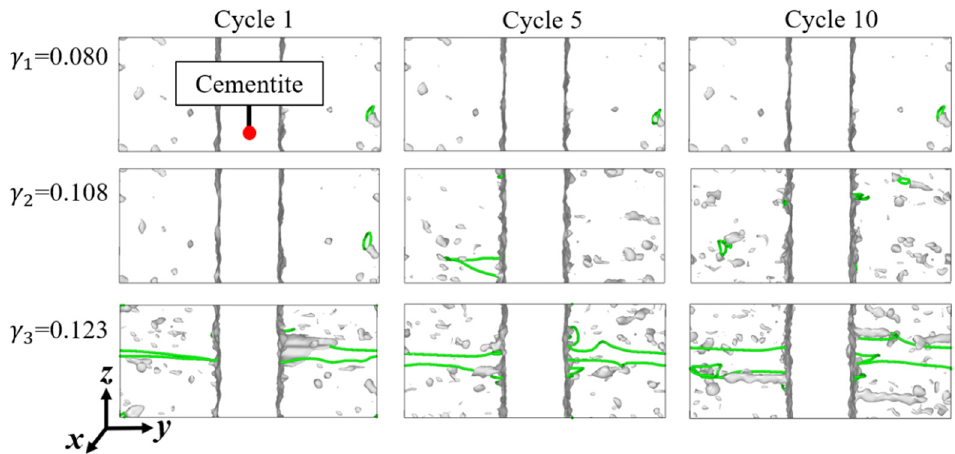
Figure 9. Dislocation distribution in the model under cyclic shear deformation along the y -axis. Features are the same as in Figure 8.